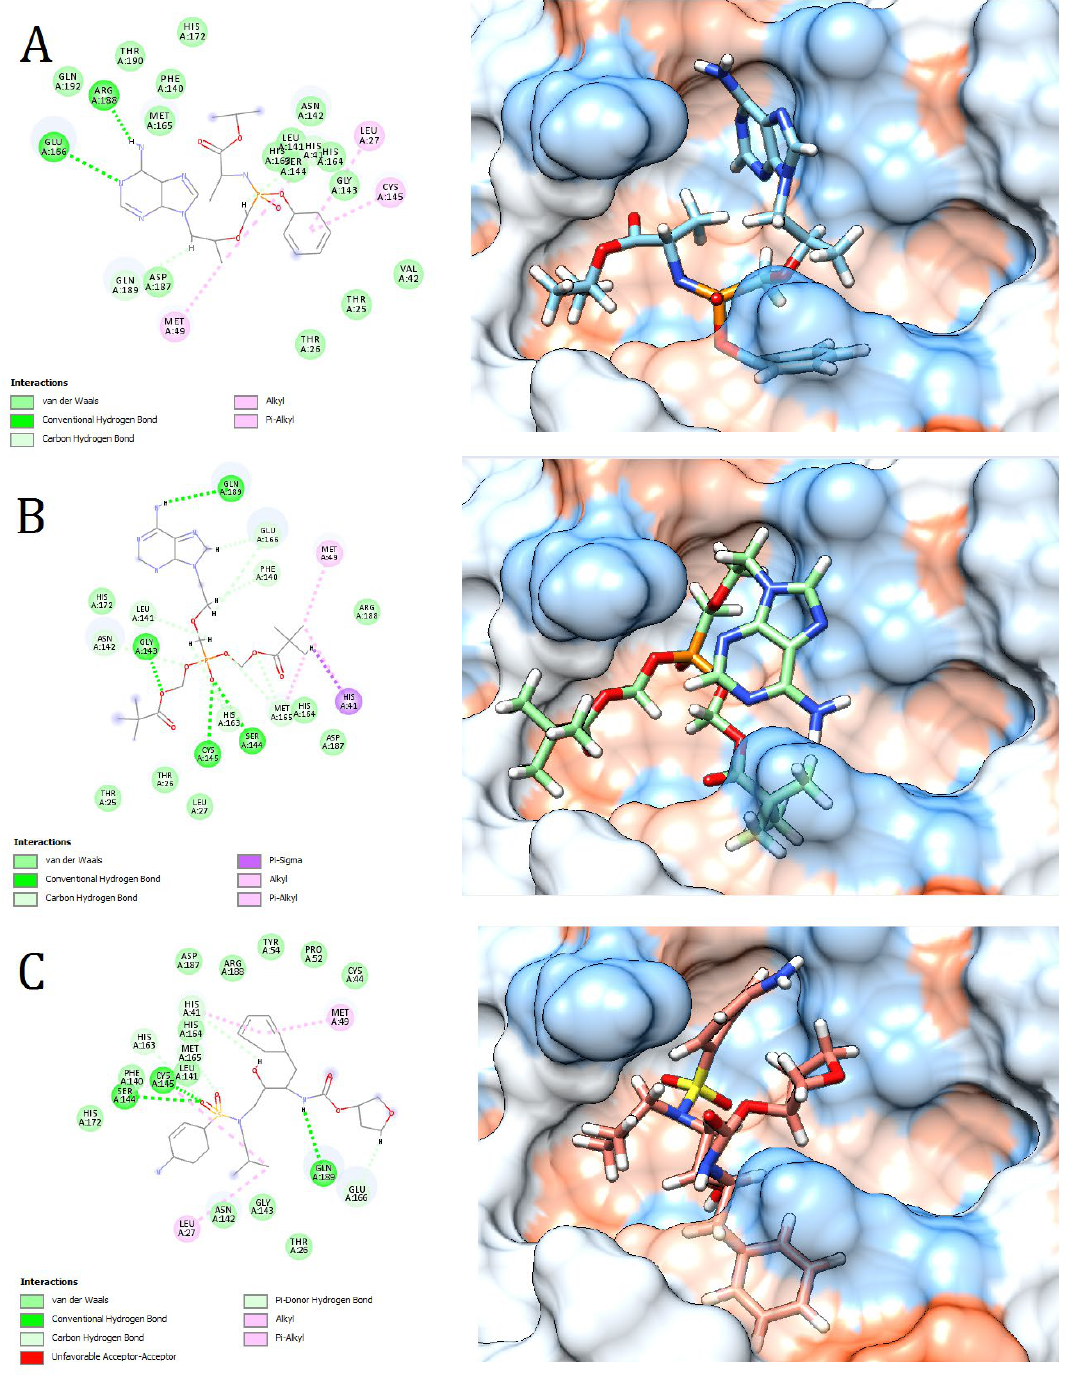
Figure 2. Docking pose visualization for the drugs with the best predicted results (Right) and their 2D receptor-ligand interaction diagram